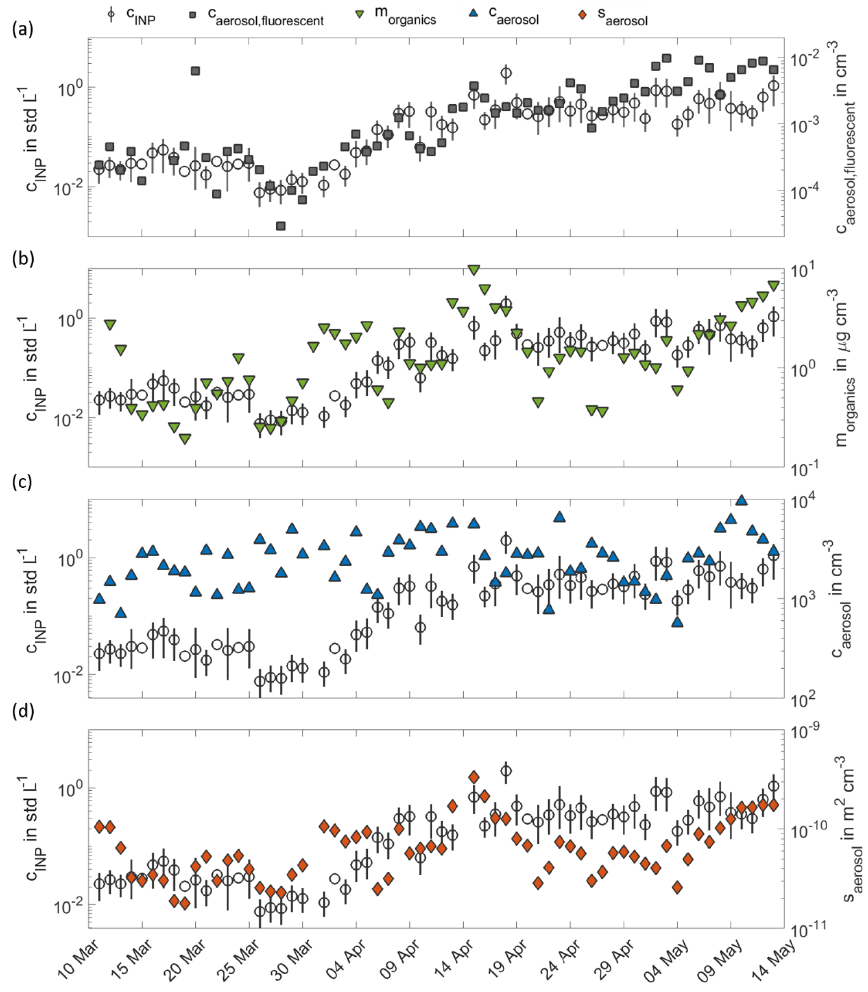
Figure 4. Factors co-varying with INP concentrations in the HyICE-2018 period. In panel (a) , INP concentrations at 257K (circles) are compared to the concentration of fluorescent aerosol particles with a fluorescence signal in group ABC (grey squares). In panels (b) , (c) and (d) , the INP concentrations are further compared to the mass concentration of non-refractory organic compounds (green triangles), the number concentration of atmospheric PM 10 aerosol (blue triangles) and the surface concentration of atmospheric PM 10 aerosol (orange